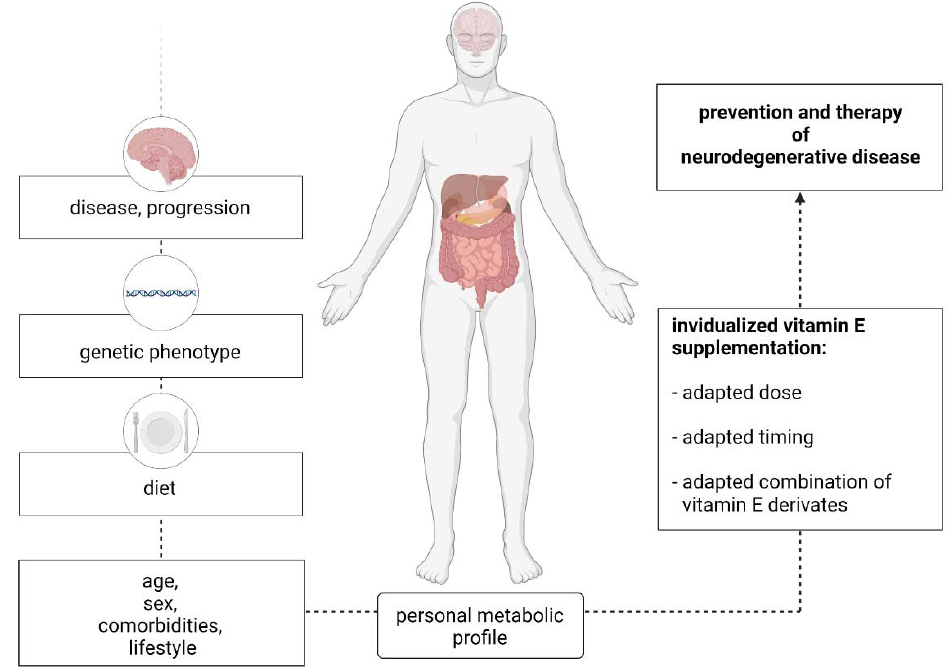
Figure 4. Individualized vitamin E supplementation and factors that should be considered beforehand.